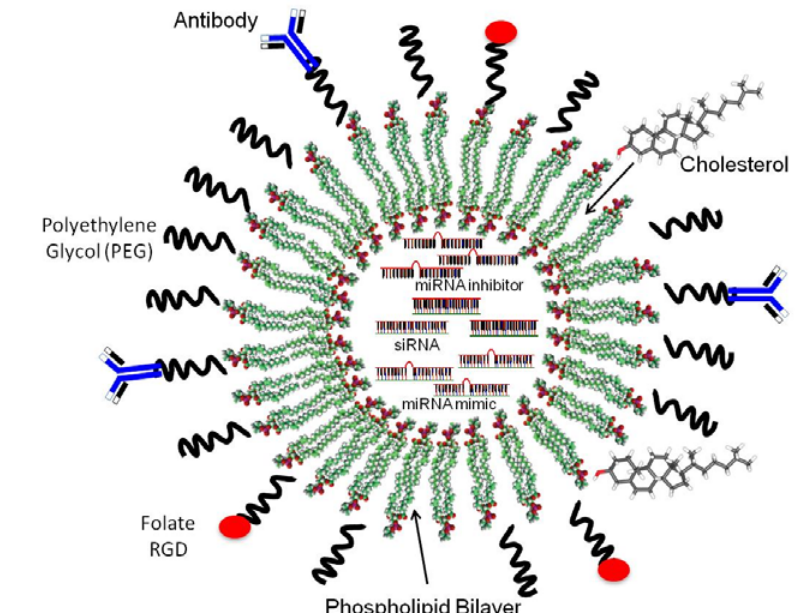
Figure 1. Nanoliposomes for drug